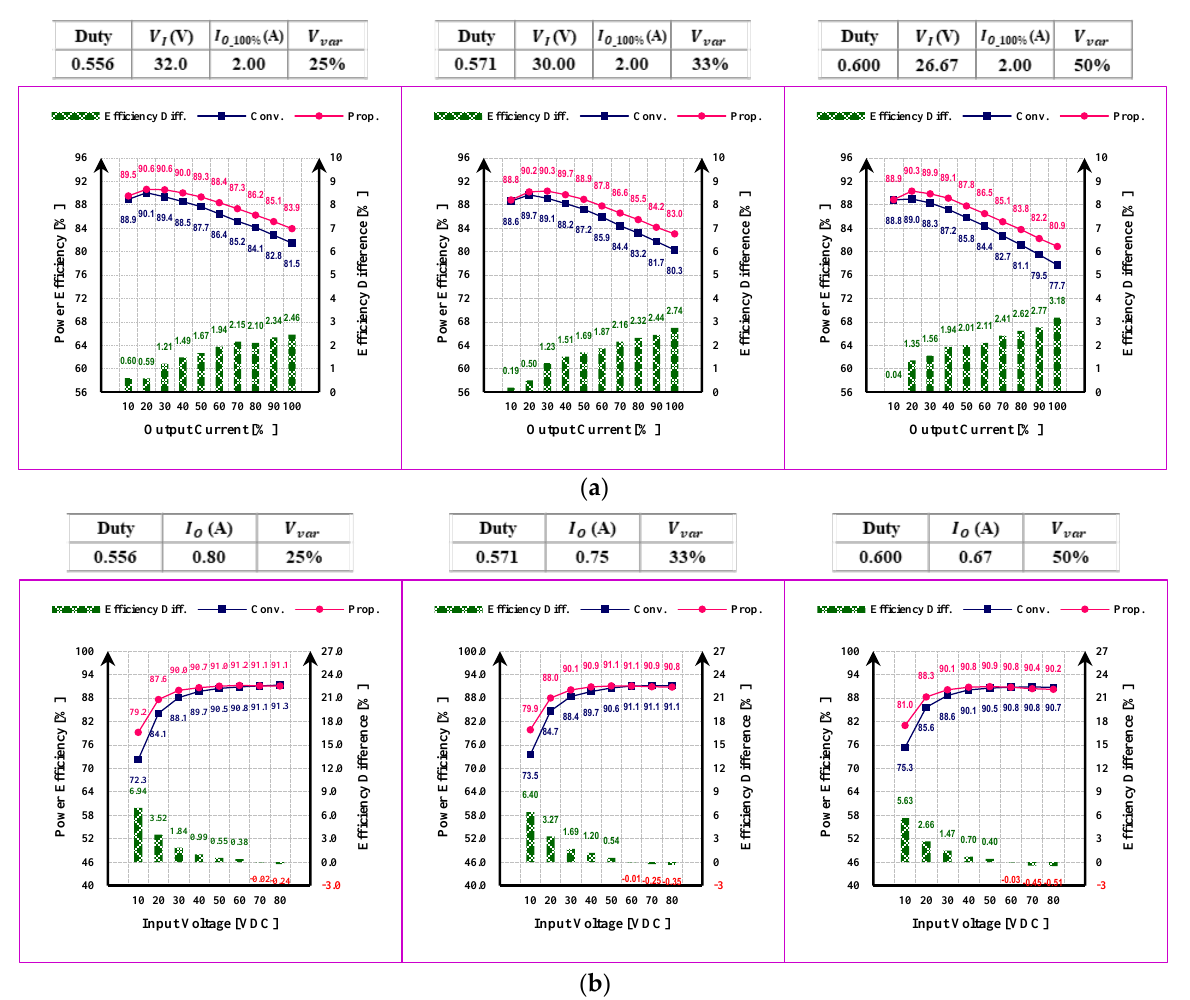
Figure 12. Power efficiency comparison of the buck-boost topology (step-up): ( a ) CV mode; ( b ) CC mode.